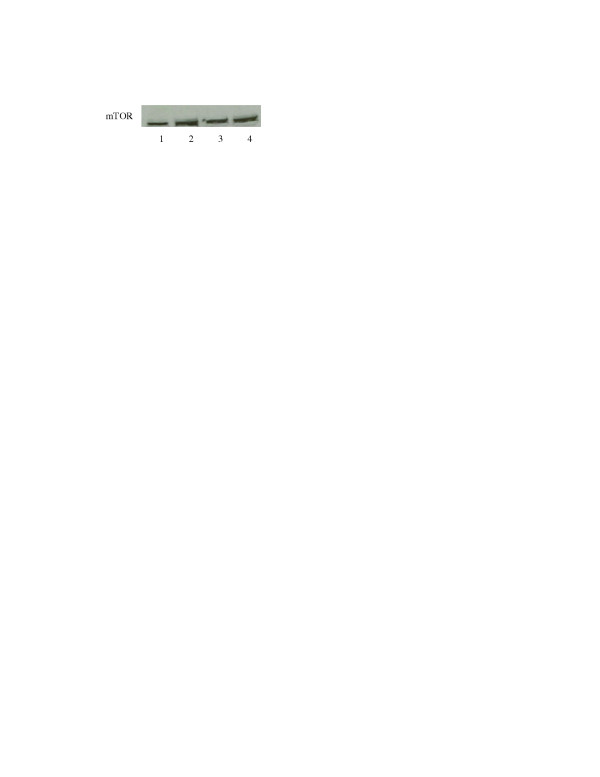
Westernblot analysis of mTOR in Lane1: SCLCB, Lane 2: SCLCBC. Lane 3: SR-2, Lane 4: SCLC1. Note: there are no differences in mTOR levels in these 4 cell lines.